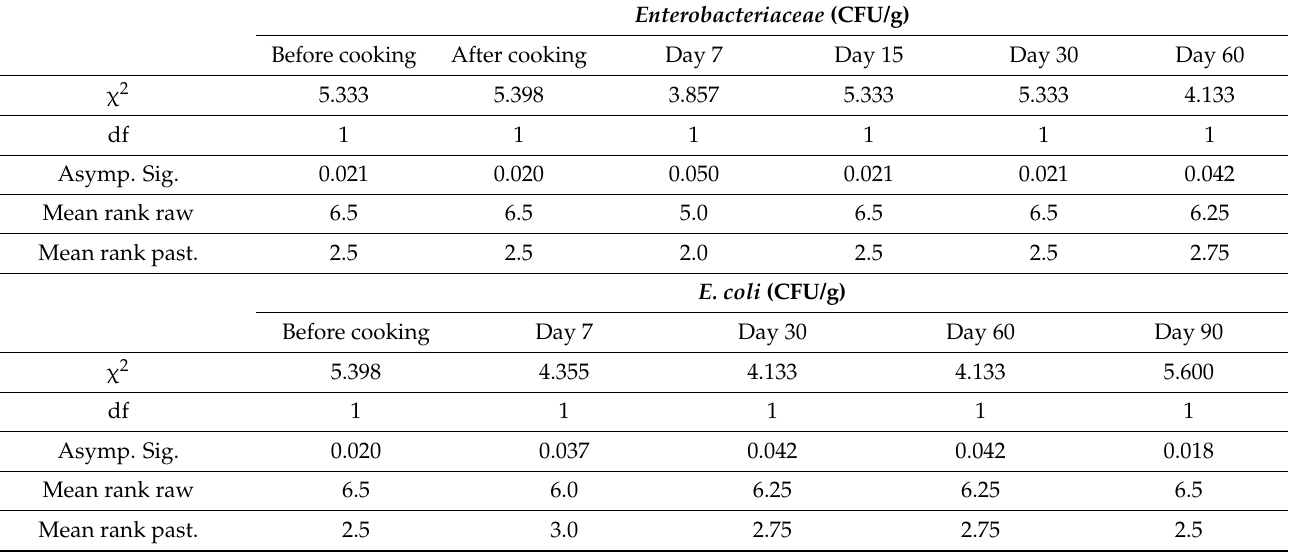
Table 3. Statistical interpretation of the microbiological analysis of raw and pasteurized curd and